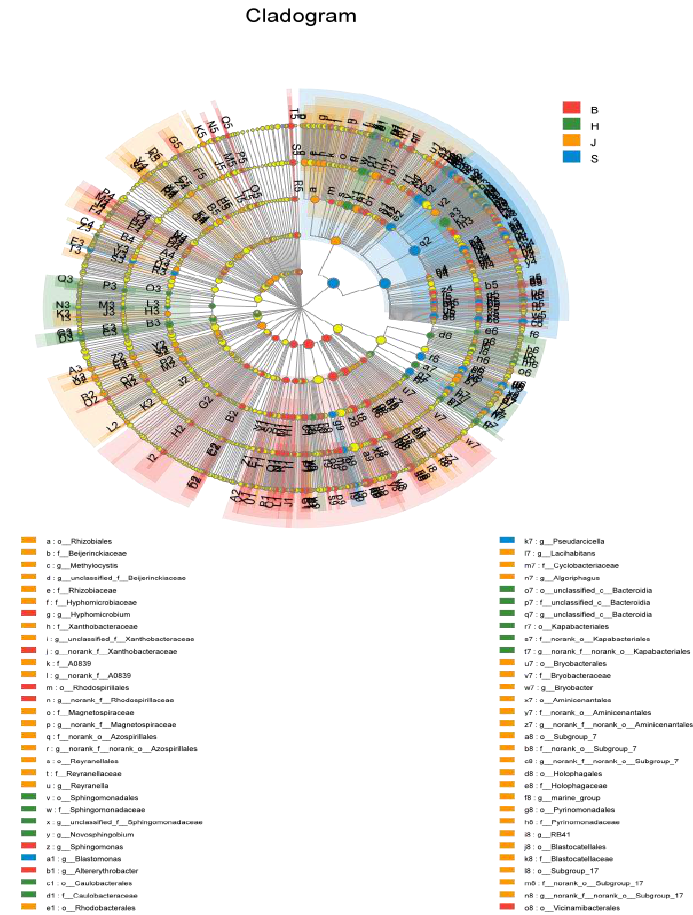
Figure 8 . H represents the Hechuan District, S represents the Shapingba District, J represents the Jiangbei District, and B represents the Beibei District; the yellow nodes represent five significantly different species, the colored nodes represent species with significant differences, and the corresponding colors represent the corresponding regions.